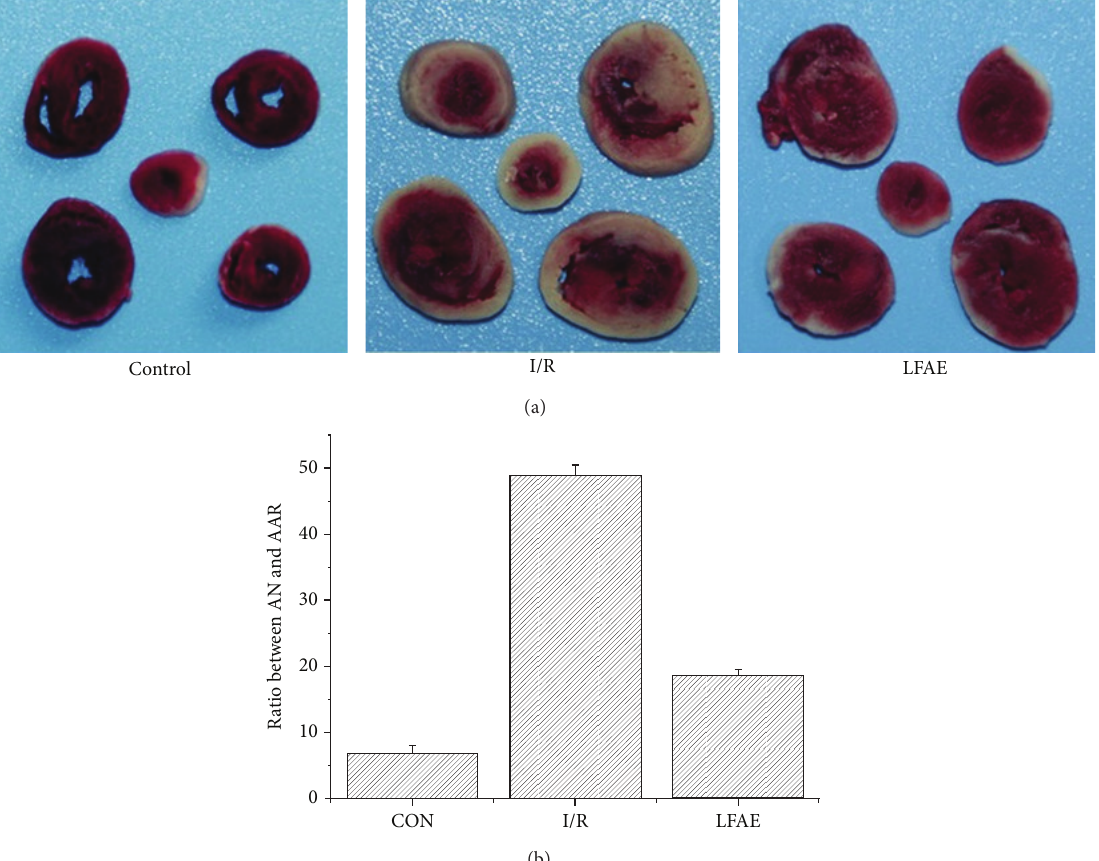
Figure 2: The aqueous extract of lavender flower (LFAE) reduces I/R-induced infarct size. (a) Photos of myocardial tissue sections of control, LFAE and I/R group, respectively, showing infarct (white) zones after TTC staining. (b) Ratio between the AN and AAR, AN is ischemic necrosis area; AAR is ischemic area. Values are means with their standard deviation ( 𝑥±𝑠 , 𝑛 = 8 ), ∗∗ 𝑃 < 0.01 compare with I/R group. CON: control group (Sham), I/R: I/R group, and LFAE: aqueous extract of lavender flower treatment